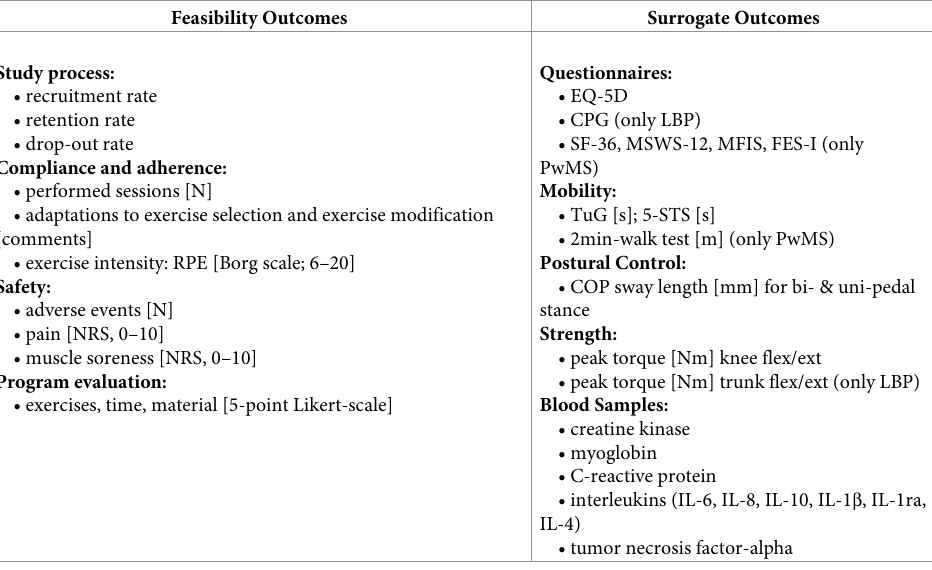
Table 1. Feasibility and surrogate outcomes of the pilot intervention